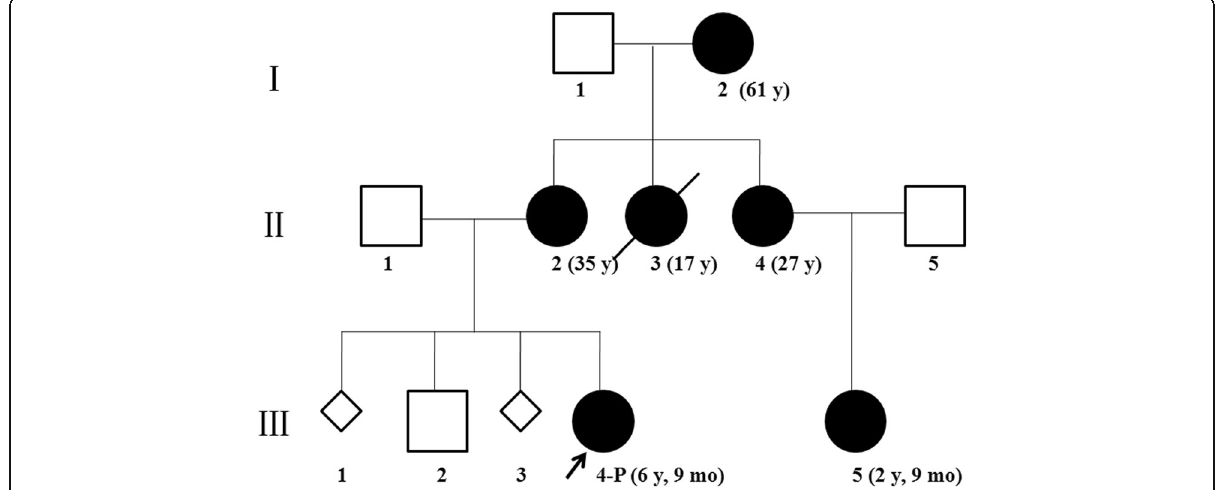
Fig. 1 The pedigree of family case with SCN8A mutation.I-2, II-2, II-4, III-2, III-4, were analyzed by whole-exome sequencing. III-5 was tested by Sanger